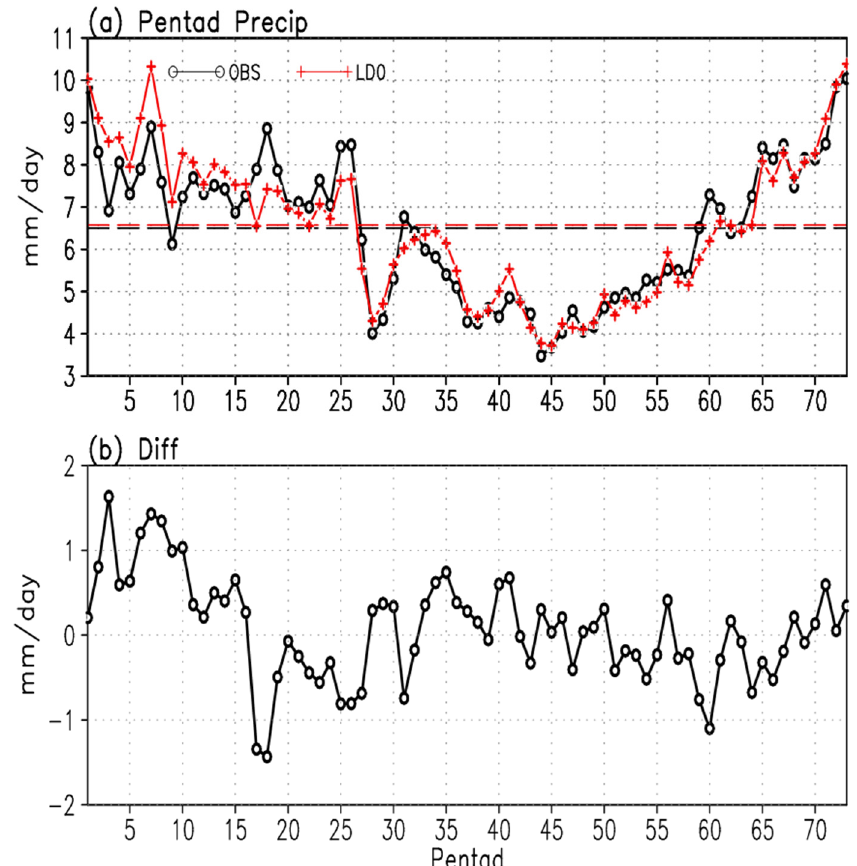
Figure 1. ( a ) Climatological pentad mean rainfall (mm/day) averaged over the Maritime Continent (9°S–1°S/98°E–145°E plus 1°S–7°N/98°E–120°E) for observation (GPCP; black line) and CFSv2 LD0 (red line); ( b ) Difference of climatological pentad mean rainfall (mm/day) between CFSv2 LD0 and observation (GPCP). The horizontal black line and red line denote the annual mean values for observation and the CFSv2, respectively.